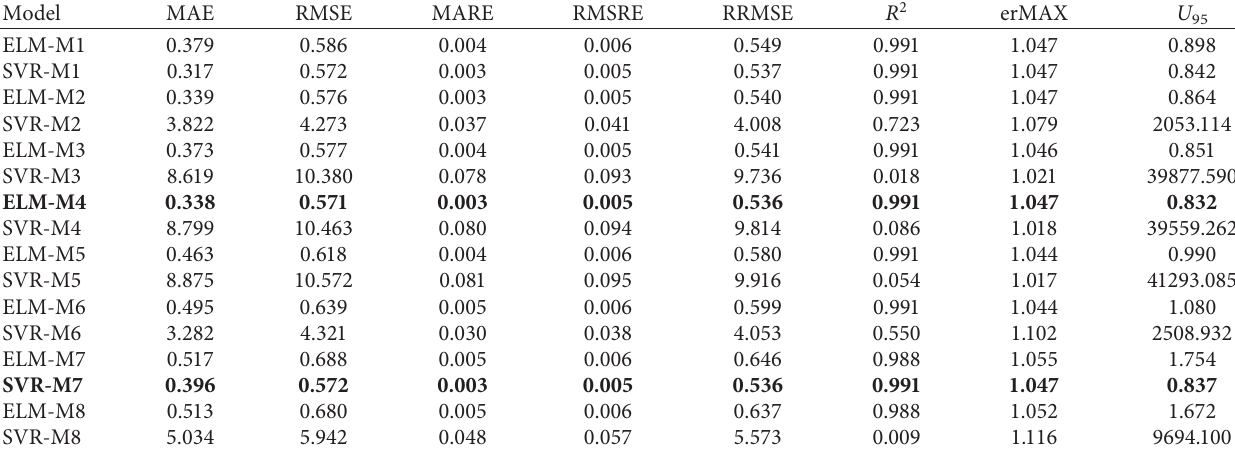
Table 6: Statistical indicators of each predicted models for USGS 14150000 station during the testing phase.